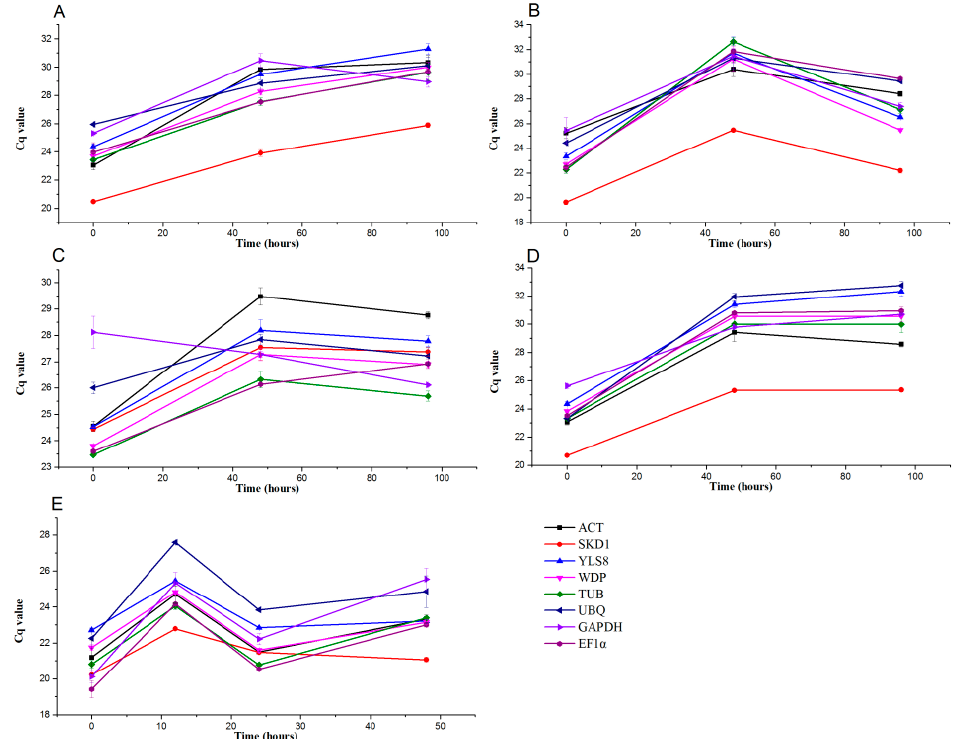
Figure 3. Transcript abundance of the eight reference genes of pear leaves under abiotic and biotic stresses measured using RT-qPCR. Cq values indicate the mean values of transcript abundance from three independent replicates ± standard errors (vertical bars). ( A ) Cold, ( B ) heat, ( C ) water deficit, ( D ) salinity, and ( E ) V. nashicola.